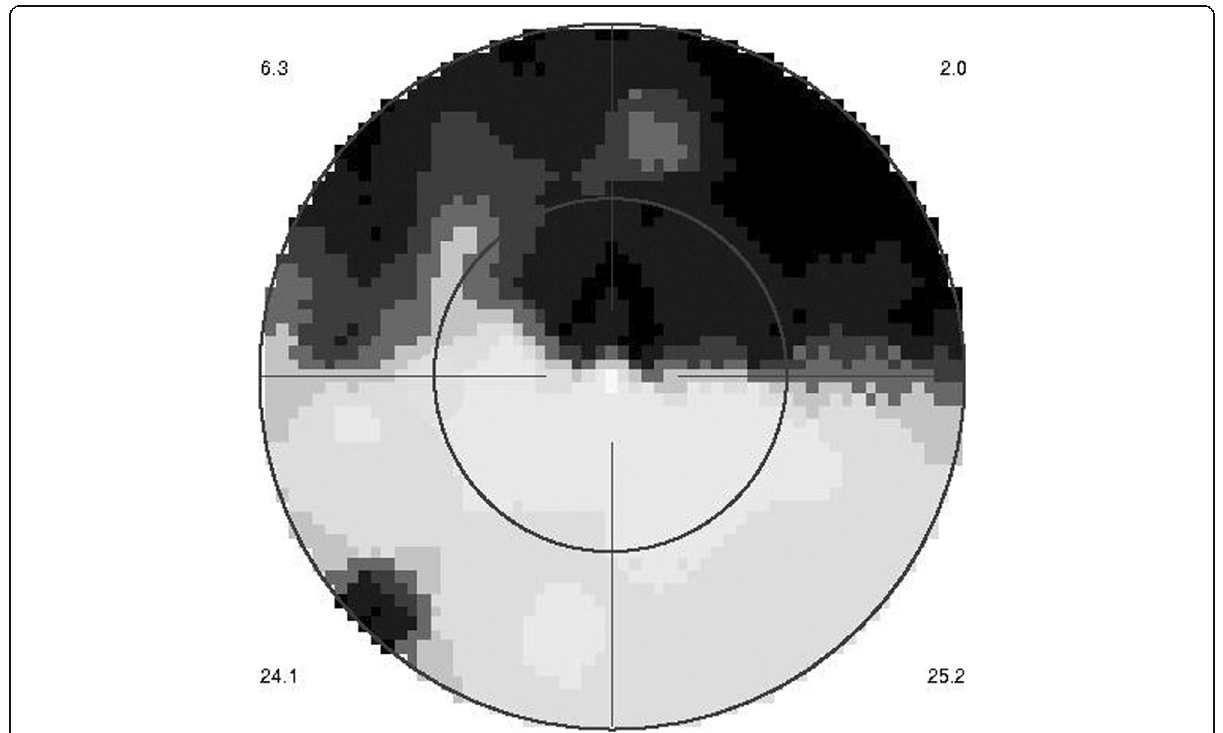
Fig. 8 Vast upper scotoma corresponding to the ischaemic infarcted lower retina delineated by microperimetry (Fig. 9) (case 1)